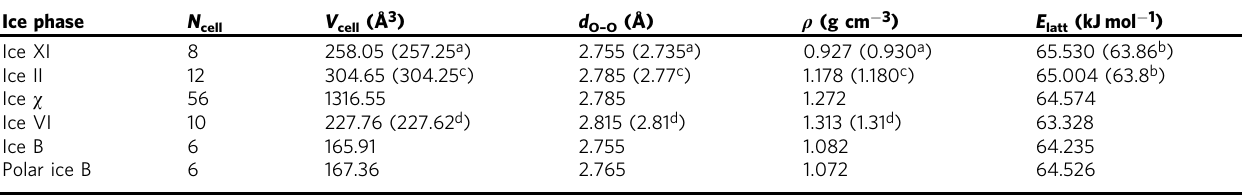
Table 1 Structural data on the ice polymorphs